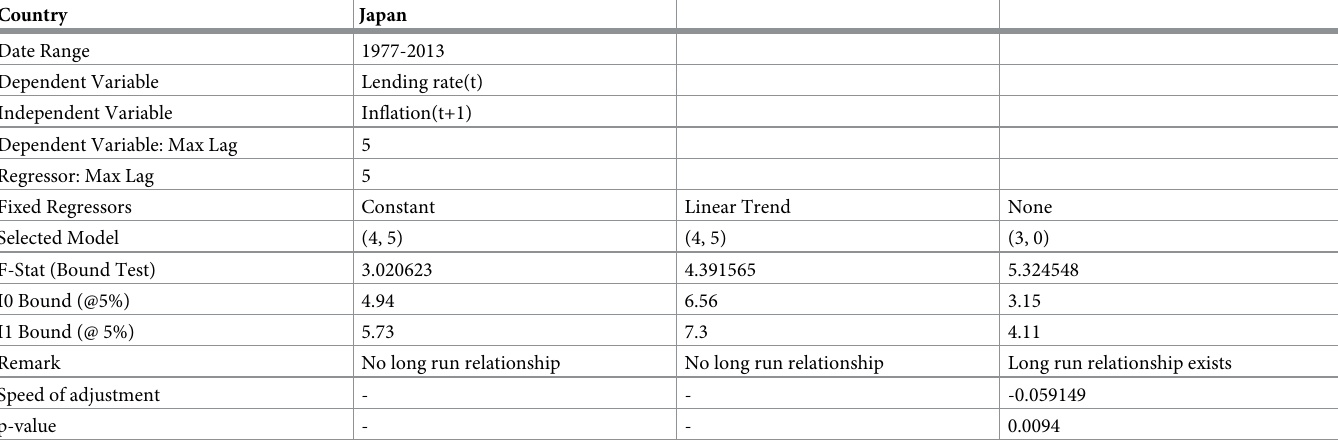
Table 26. ARDL Bounds Testing for Japanese data under Fisherian framework.